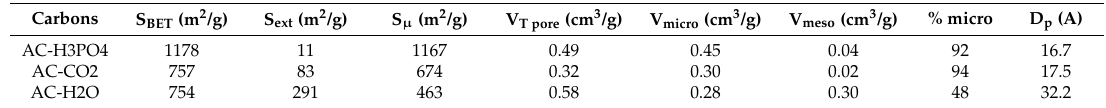
Table 1. Textural parameters of the activated